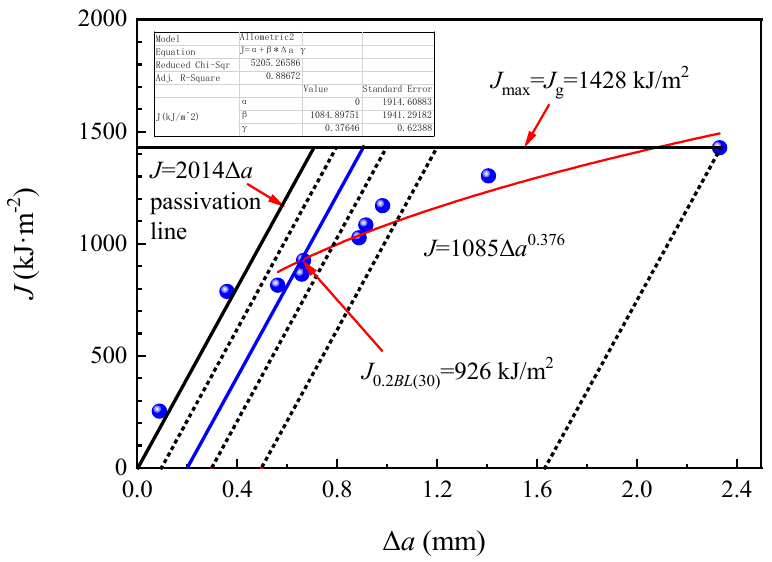
Figure 12. J - Δ a resistance curve of EH36 steel plate.